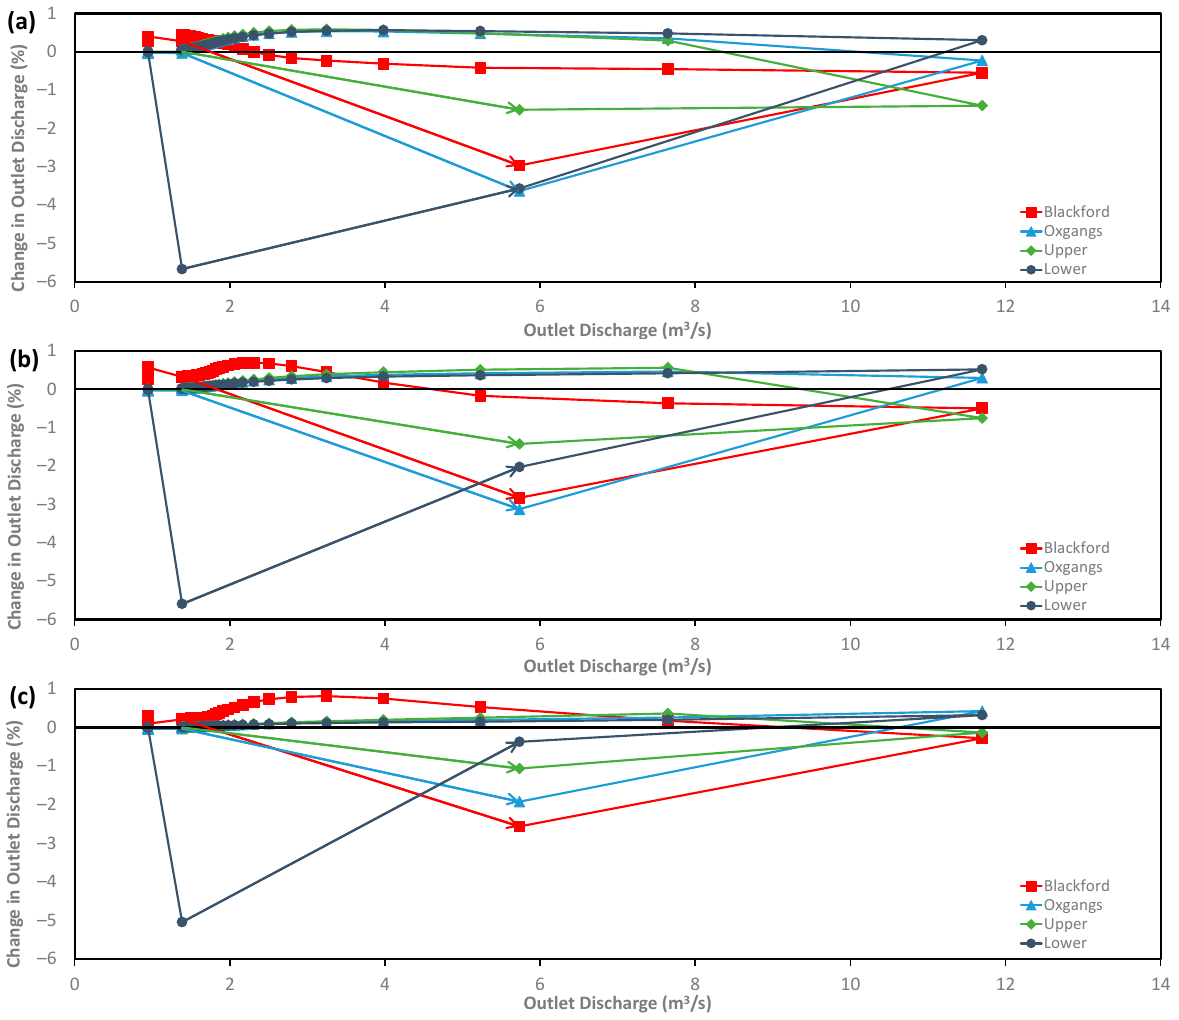
Figure 7. Baseline outlet discharge flow plotted against the change in discharge for each pond for a 1 in 100 year 1 h event. The dots represent every hour, and the arrows show the increasing time through the model simulation. ( a ) increased storage, ( b ) standard storage, ( c ) decreased storage.